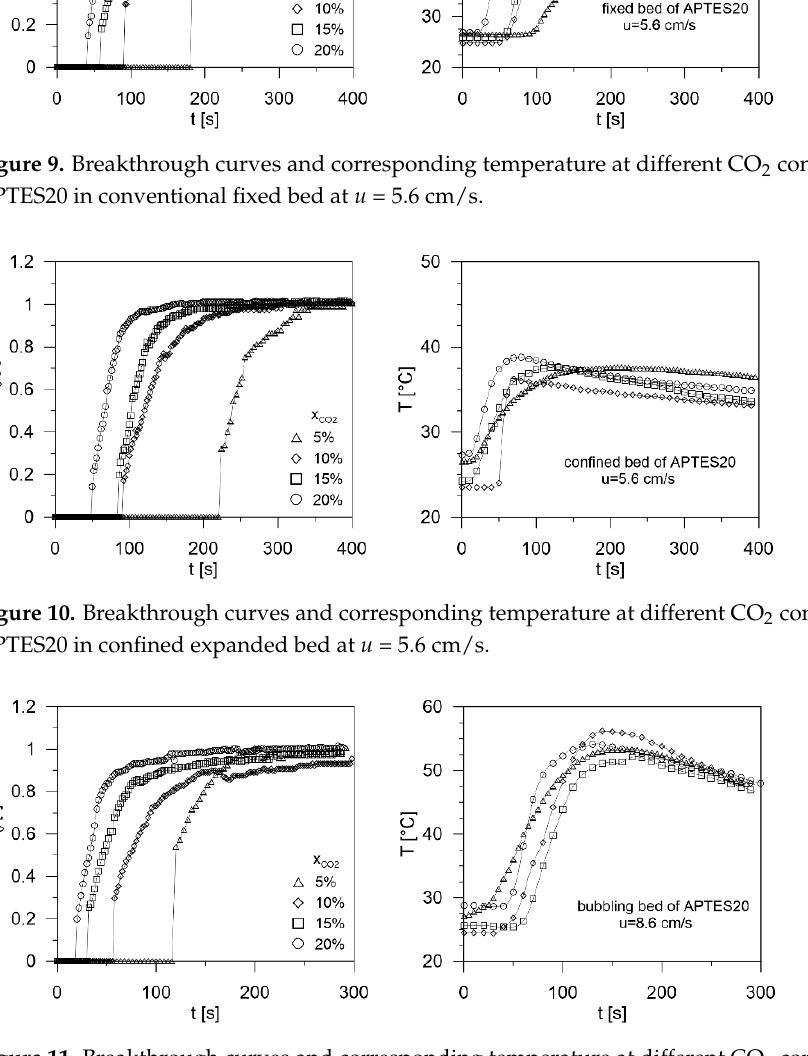
Figure 12. Breakthrough curves and corresponding temperature at different CO 2 concentrations for APTES20 in confined expanded bed at u = 8.6 cm/s. The occurring of the bubbling regime had already reduced the temperature in the conventional layout (see Figure 11), while only the homogeneous fluidization of the particles in the confined bed allows controlling the increase in the temperature into a range of at most 10 °C (see Figures 10 and 12). 3.4. Effect of the Velocity of the Inlet Gas Figures 13 and 14, showing the curves obtained for the adsorption of the 15% CO 2 gas mixture, are compared at different values of velocity and at the same layout. Even though the increased velocity reduces the contact times and the breakthrough time, the bubbling regime showed better control of the temperature, lower than the 59% respect to that maximum value reached the fixed bed (ca. 50 °C) (see Figure 13). Figure 14 shows the similar effect of the velocity in the confined bed: also in this case, at higher velocity corresponds a lower characteristic time of adsorption; moreover, a reduction in